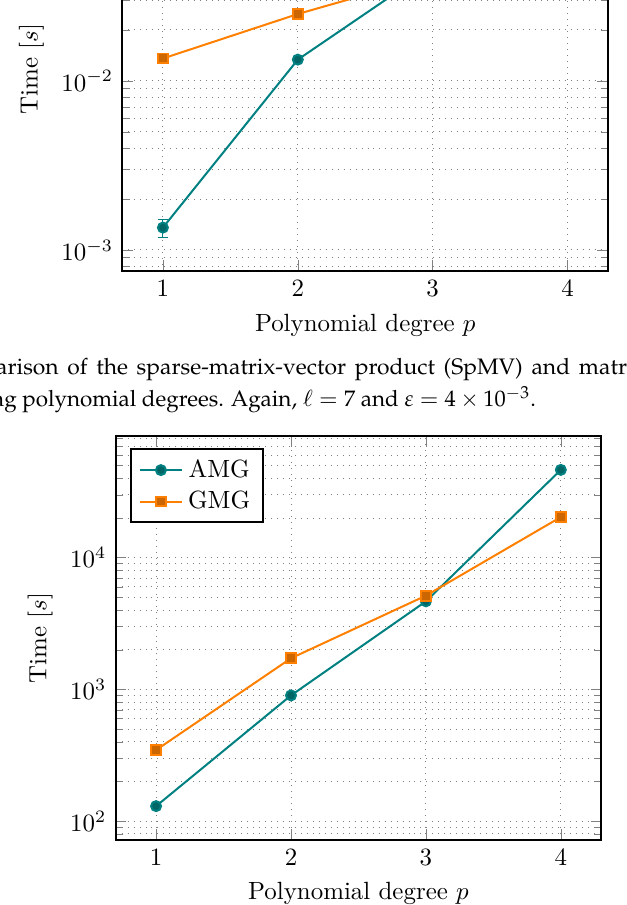
Figure 11. Total time spent solving the linear system for a full simulation of the single-edge notched shear test using 16 cores. This includes setup times for the sparse-matrix and AMG solver as well as the eigenvalue computation and setup routines required for the MF-GMG. Again, (cid:96) = 7 and ε = 4 × 10 − 3